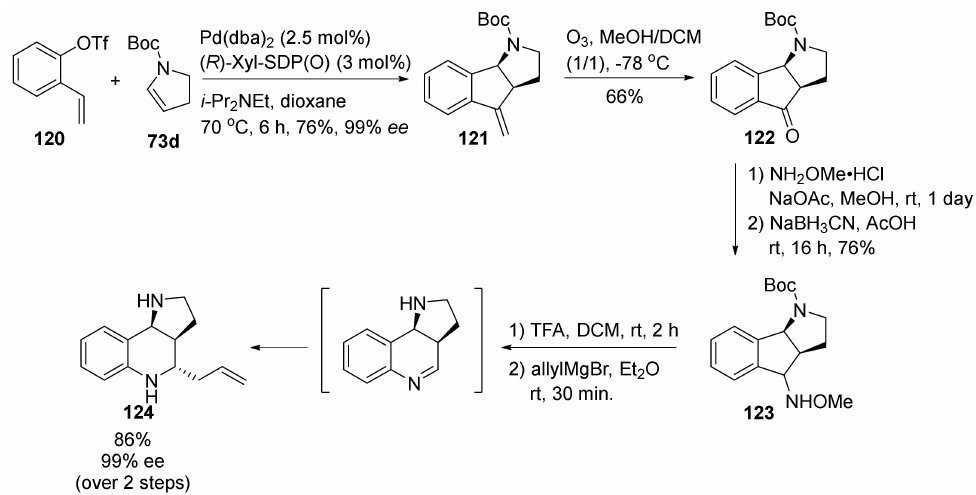
Scheme 19. Scaffold synthesis by Zhou and co-workers.